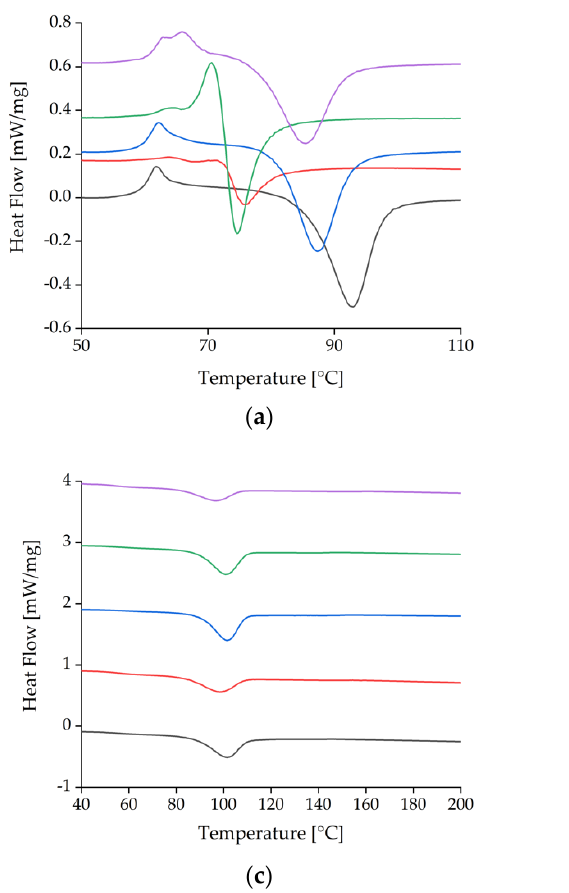
Figure 7. Differential scanning calorimetry thermograms for the first heating cycle of BHET-containing fibers at different take-up velocities and draw ratios. ( a ) Detailed view of the glass-transition temperature T g and cold-crystallization temperature T cc . ( b ) Melting temperature T m . ( c ) Crystallization temperature T c during cooling. Table 4. Differential scanning calorimetry data for Figure